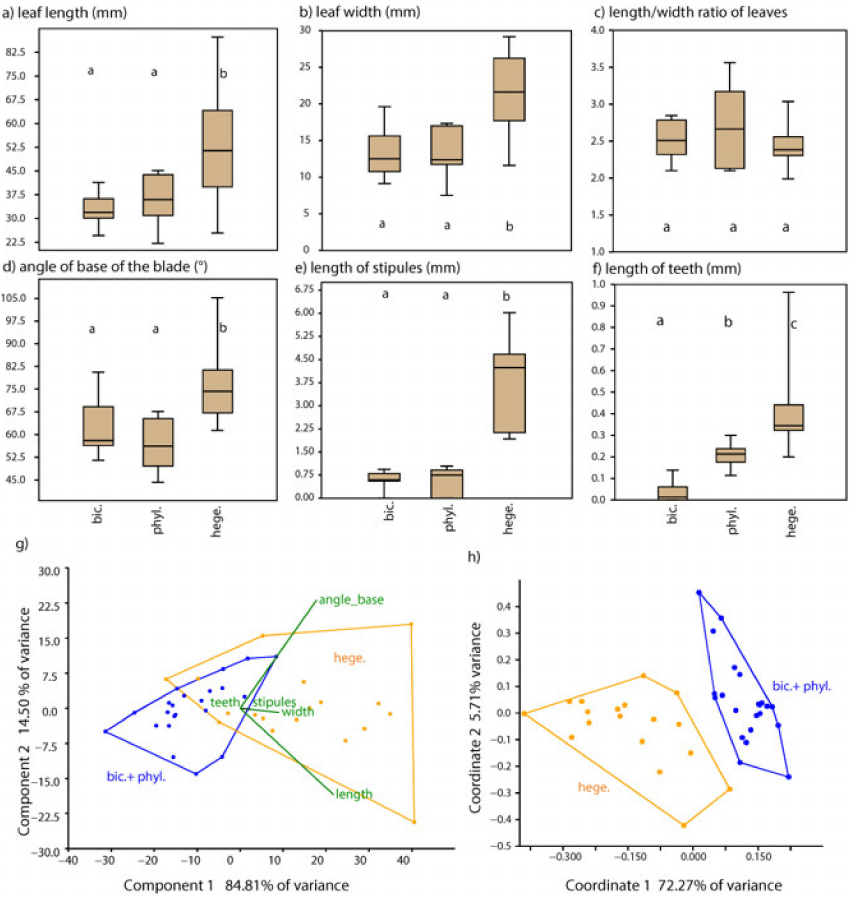
Figure 5. Morphometric analyses. ( a – f ) Boxplots of six characters plotted for S. bicolor (n = 15,